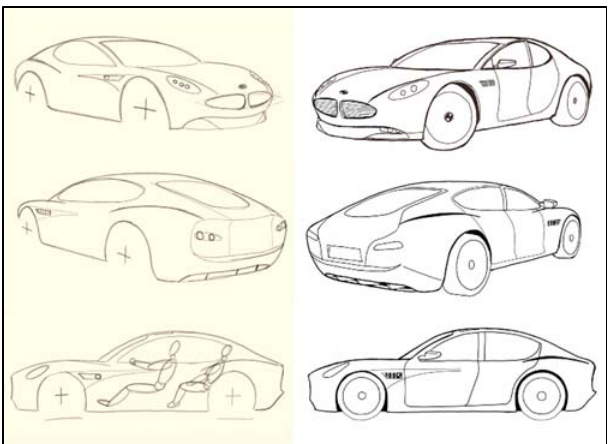
Figure 9. Sketches of the retro